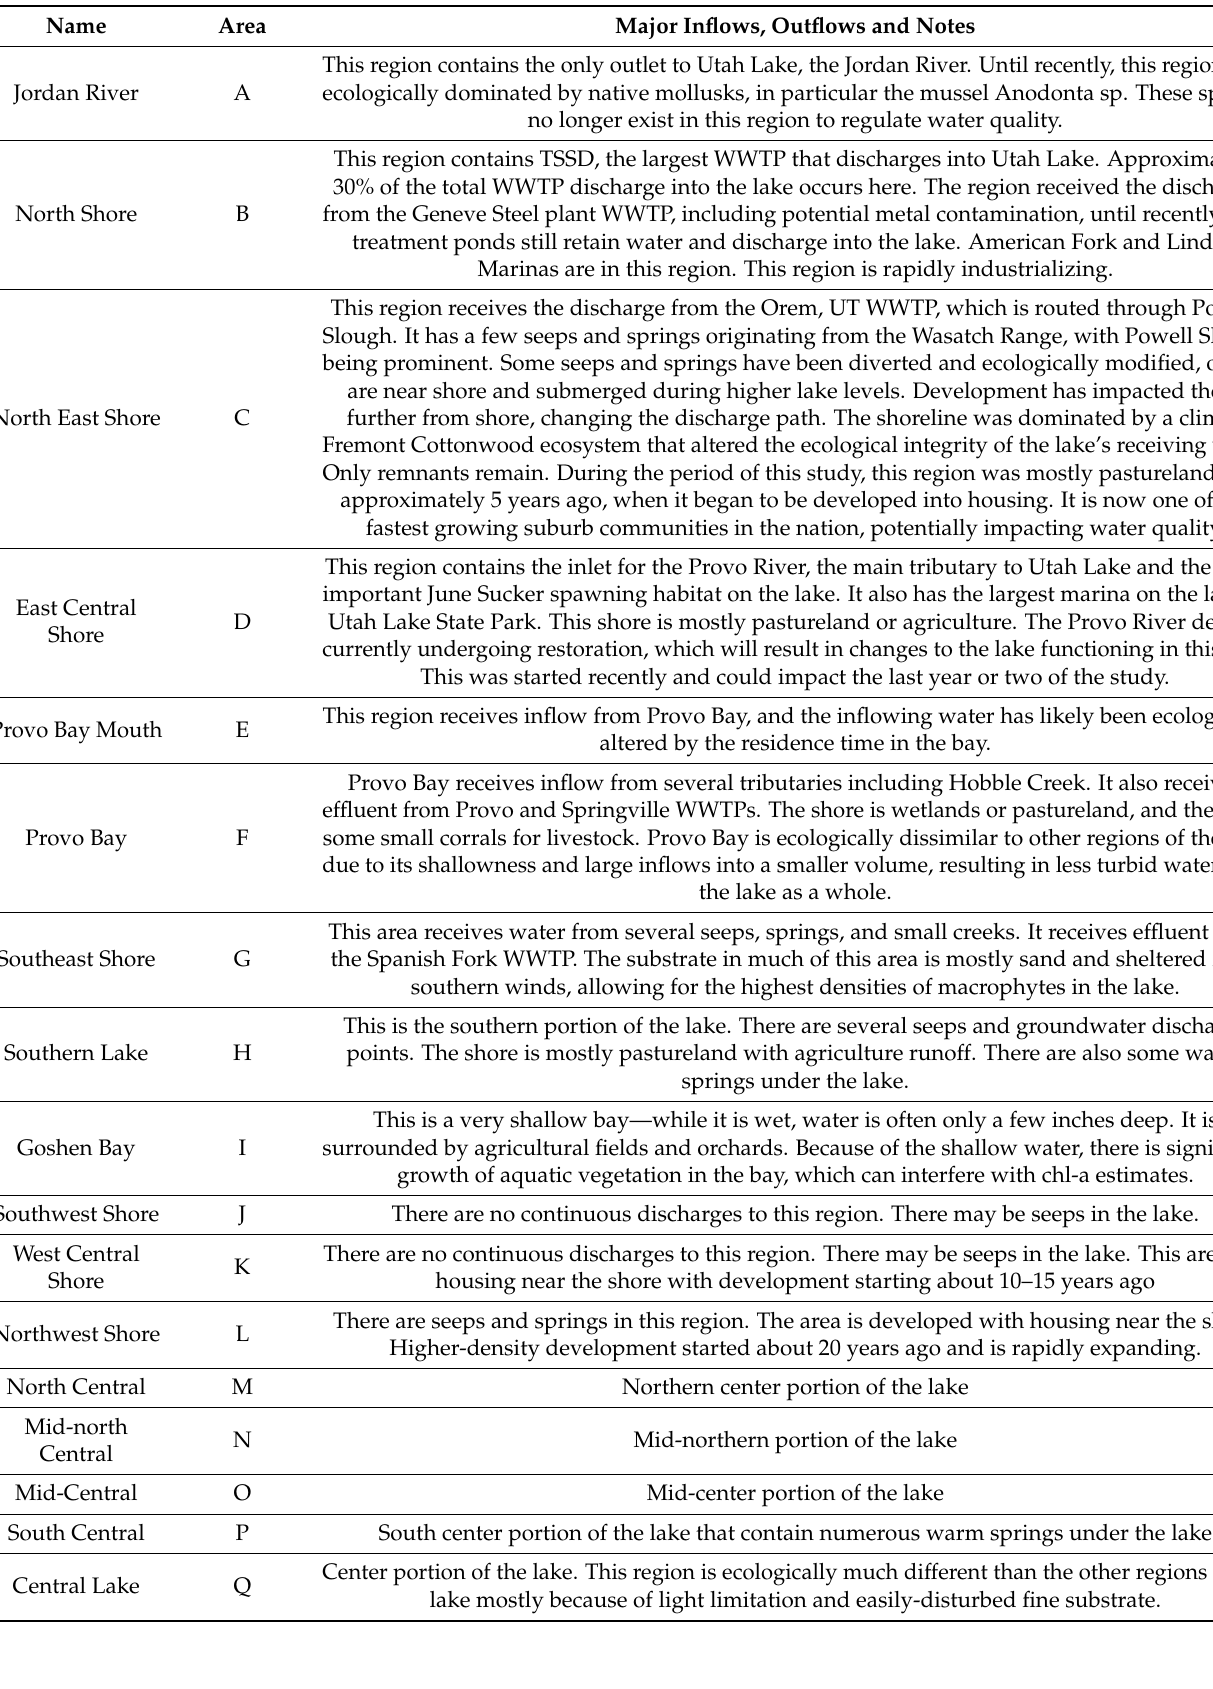
Table 2. Utah Lake Statistical Analysis regions. The letter designations are from Figure